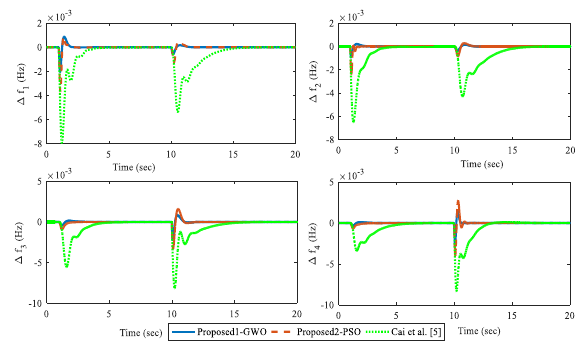
Fig. 26 Comparison of frequency deviation for FAPS in case study 6